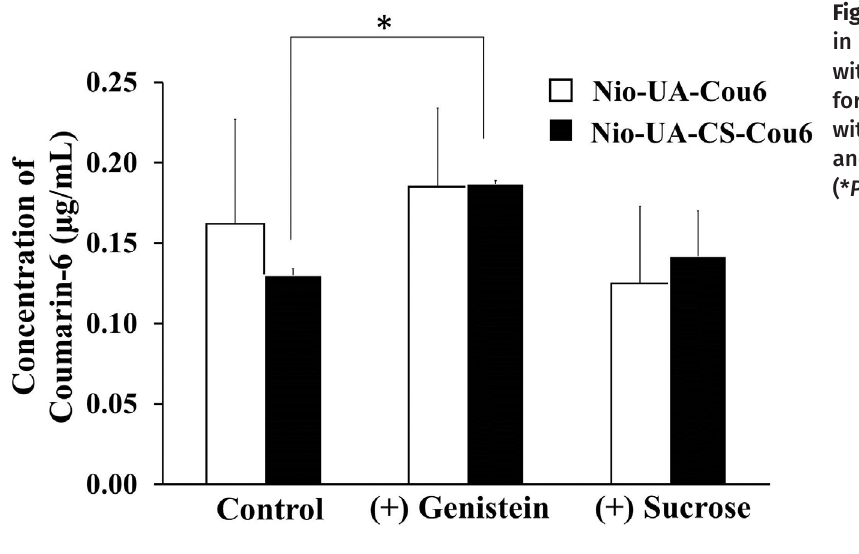
Figure 3. Coumarin-6 levels in HeLa cells after incubation with Nio-UA and Nio-UA-CS for two hours without and with addition of genistein and sucrose